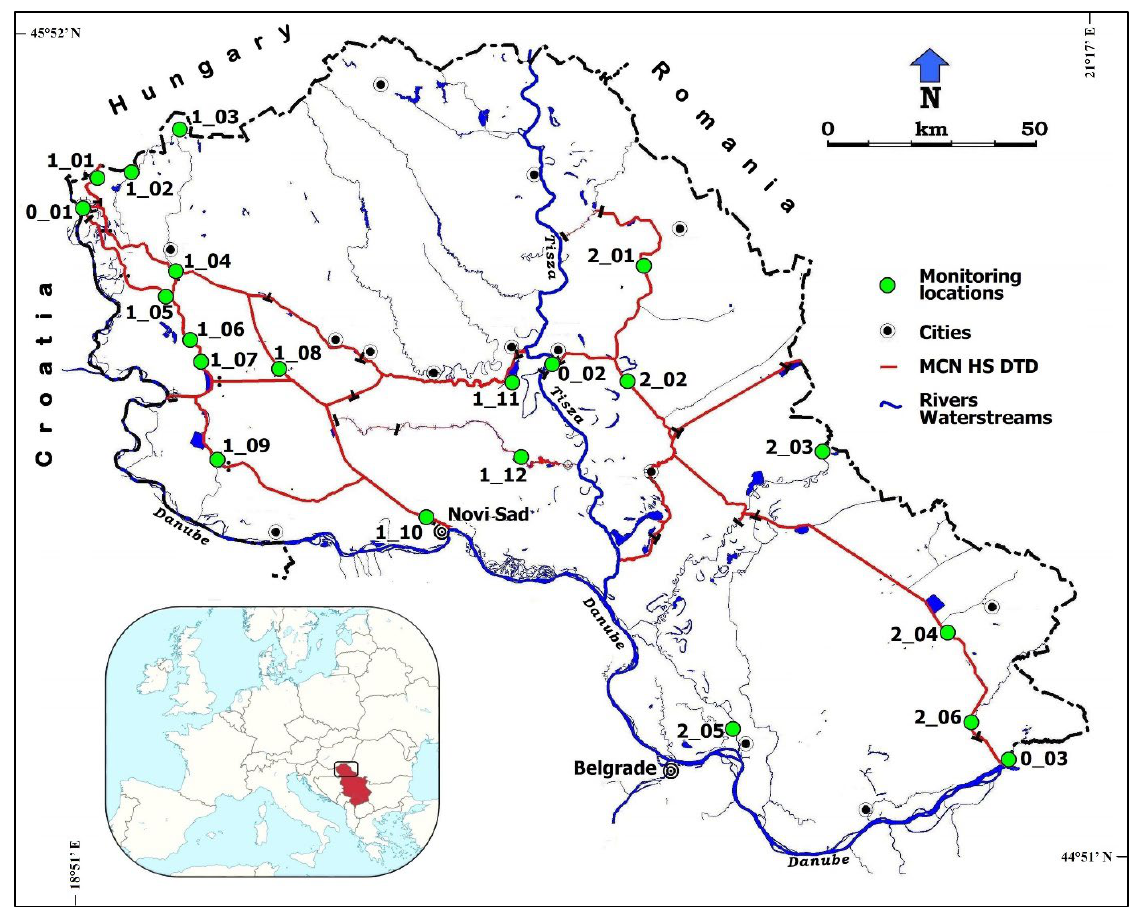
Figure 1. Study area with the monitoring stations on the main canal network of the HS DTD catch- ment.